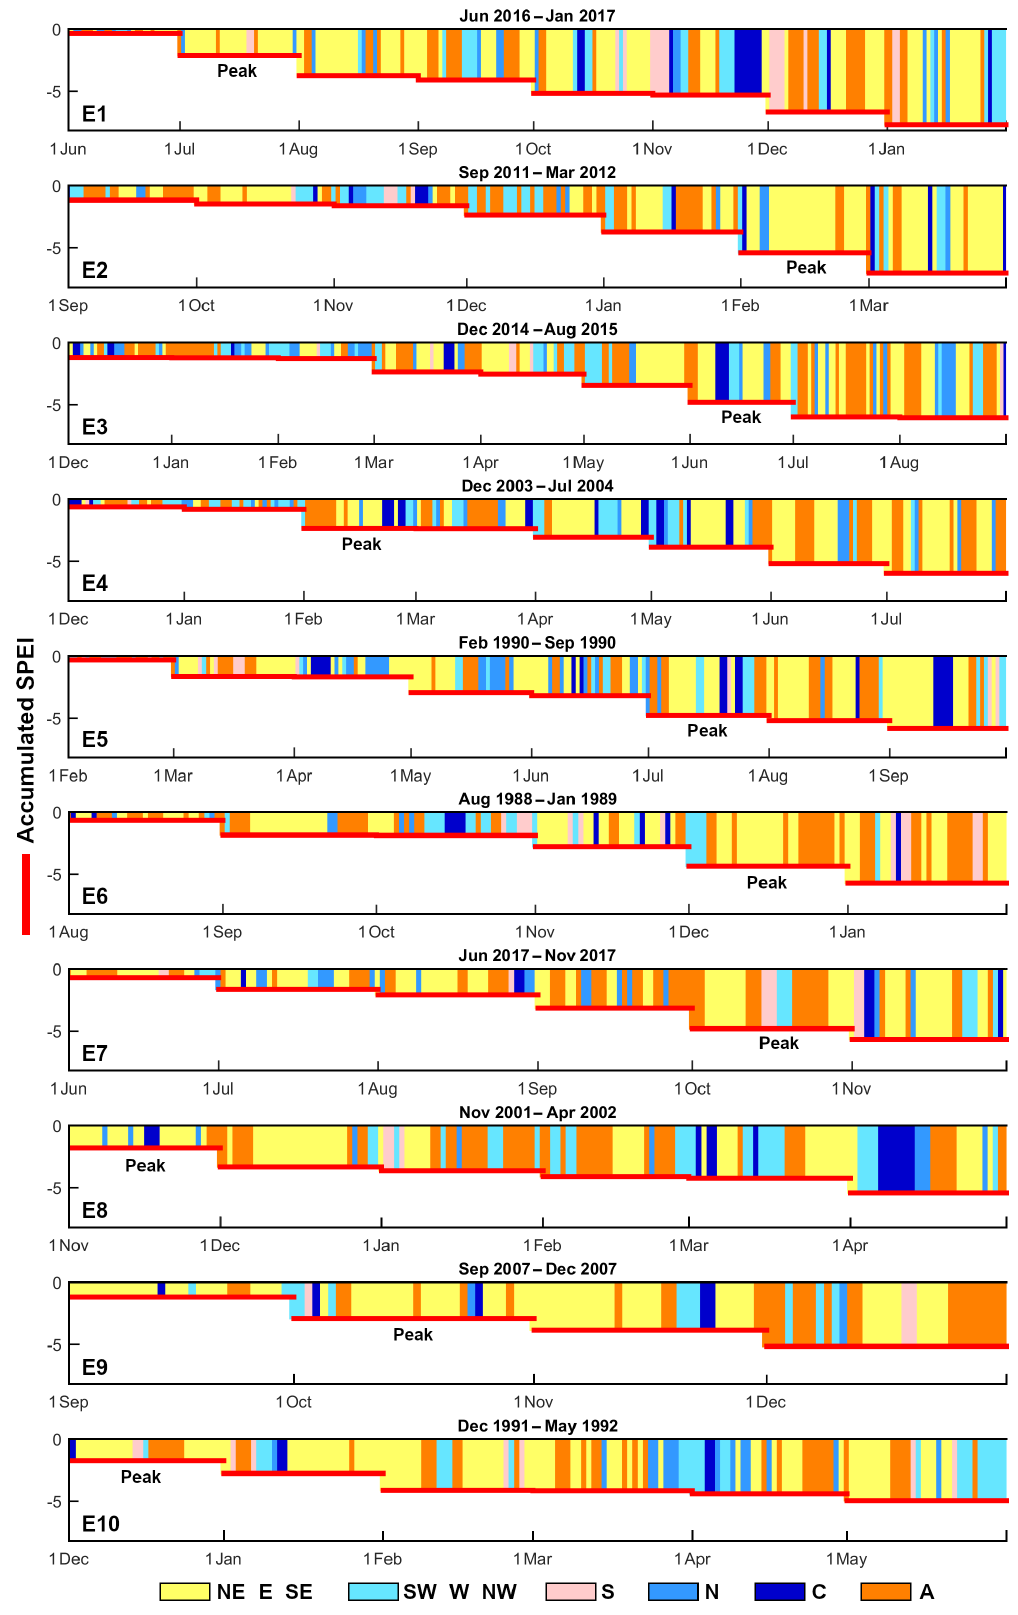
Figure 12. Accumulated SPEI1 (red line) and grouped CWTs during the 10 most severe drought episodes listed in Table